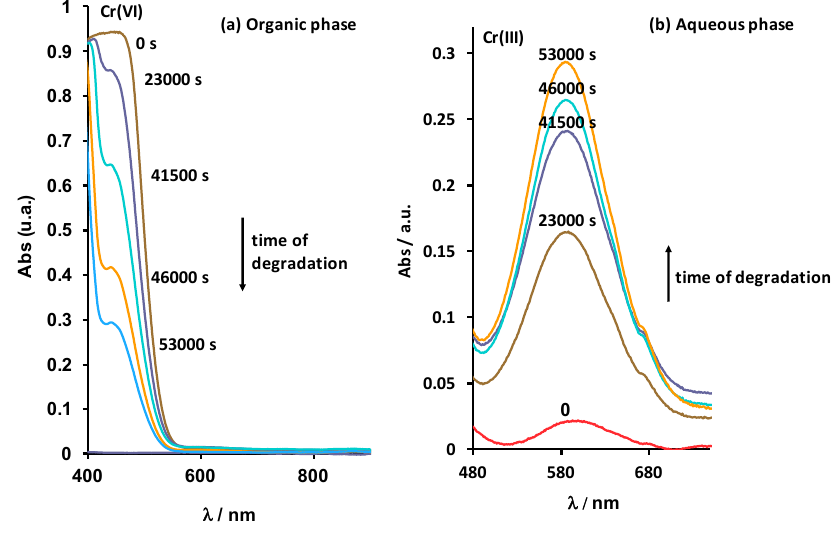
Figure 2. ( a ) UV-Visible spectra of the organic phase throughout the degradation (organic phase contained initially 0.2 mol·kg − 1 tri- n- octylamine diluted in n- dodecane modified with 5 wt % 1-tridecanol + 0.05 mol·kg − 1 Cr(VI); ( b ) UV-Visible spectra of the aqueous phase in contact with the organic phase throughout the chemical degradation of the organic phase. Temperature = 25 °C.